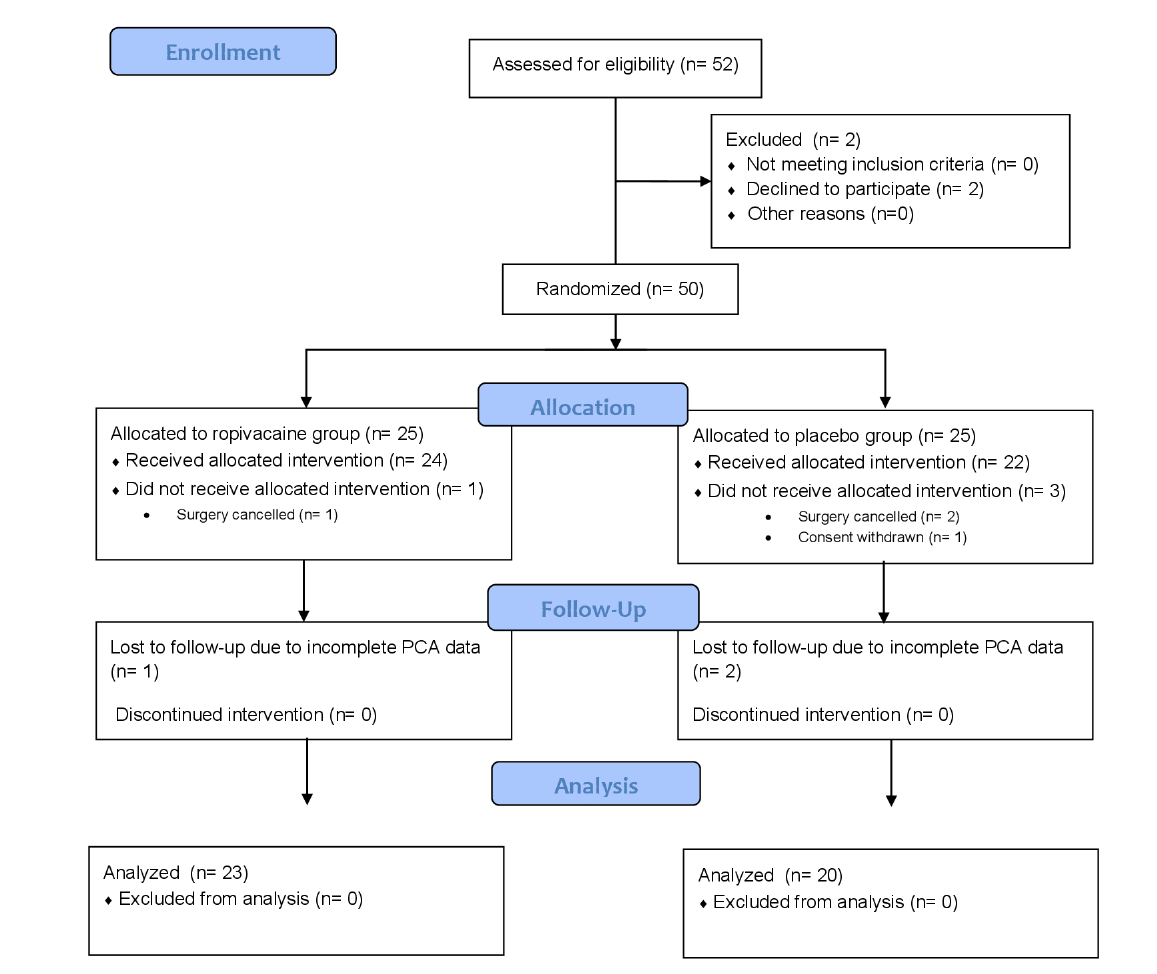
Figure 1: Consolidated Standards of Reporting Trials (CONSORT) flow diagram. PCA, patient–con- trolled